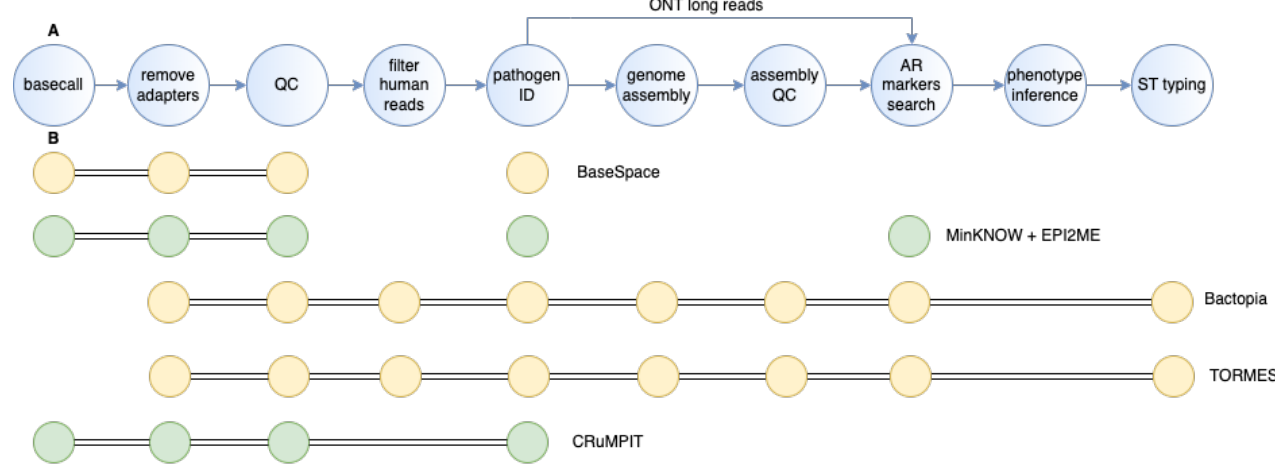
Figure 1. Pipelines for sequencing data analysis for clinical application. ( A ) Analysis steps need to be performed for pathogen identification and resistance markers search in clinical samples. ( B ) Existing pipelines and steps they include. Yellow—Illumina data only; green—ONT data only. Connected dots represent steps that are automatically performed in the workflow, whereas isolated dots represent independent analysis steps that need to be called by the user. The figure was created using draw.io.